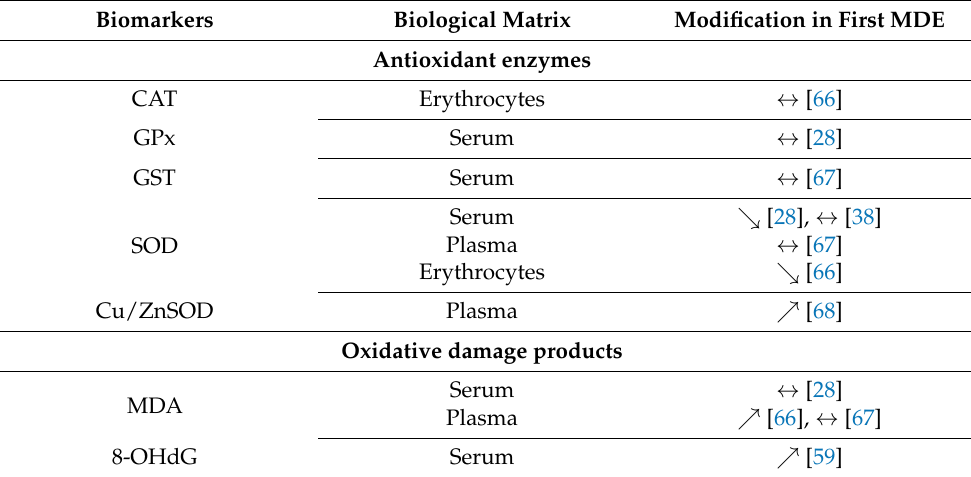
Table 3. Peripheral biomarkers of oxidative stress in patients with a first major depressive episode compared to healthy controls. MDE: Major depressive episode—CAT: Catalase—GPx: Glutathion Peroxydase—GST: Glutathion-S-Transferase—SOD: Superoxide dismutase (information about iso- form was not provided)—Cu/ZnSOD: Type 1 isoform of SOD—MDA: Malondialdehyde—8-OHdG: